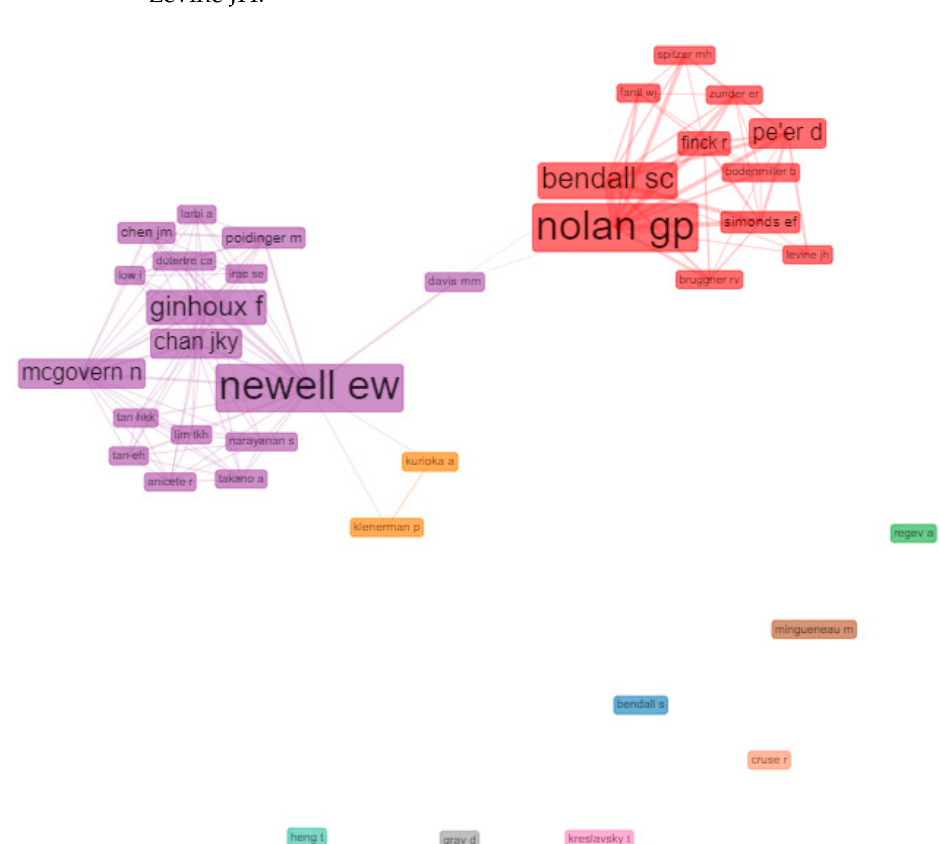
Figure 5. Clusters of most relevant author collaboration networks in mass cytometry’s HCPs. Network parameters: field (authors), normalization (No), clustering algorithm (Louvain), network Layout (automatic layout), number of nodes (37), remove isolated nodes (No), and minimum edges (2). Graphical parameters: opacity (0–0.7), number of labels (5–50), label cex (Yes), label size (0–6), node shape (Box), edge size (0.1–5), curved edges (No). The figure was created using Biblioshiny web interface.